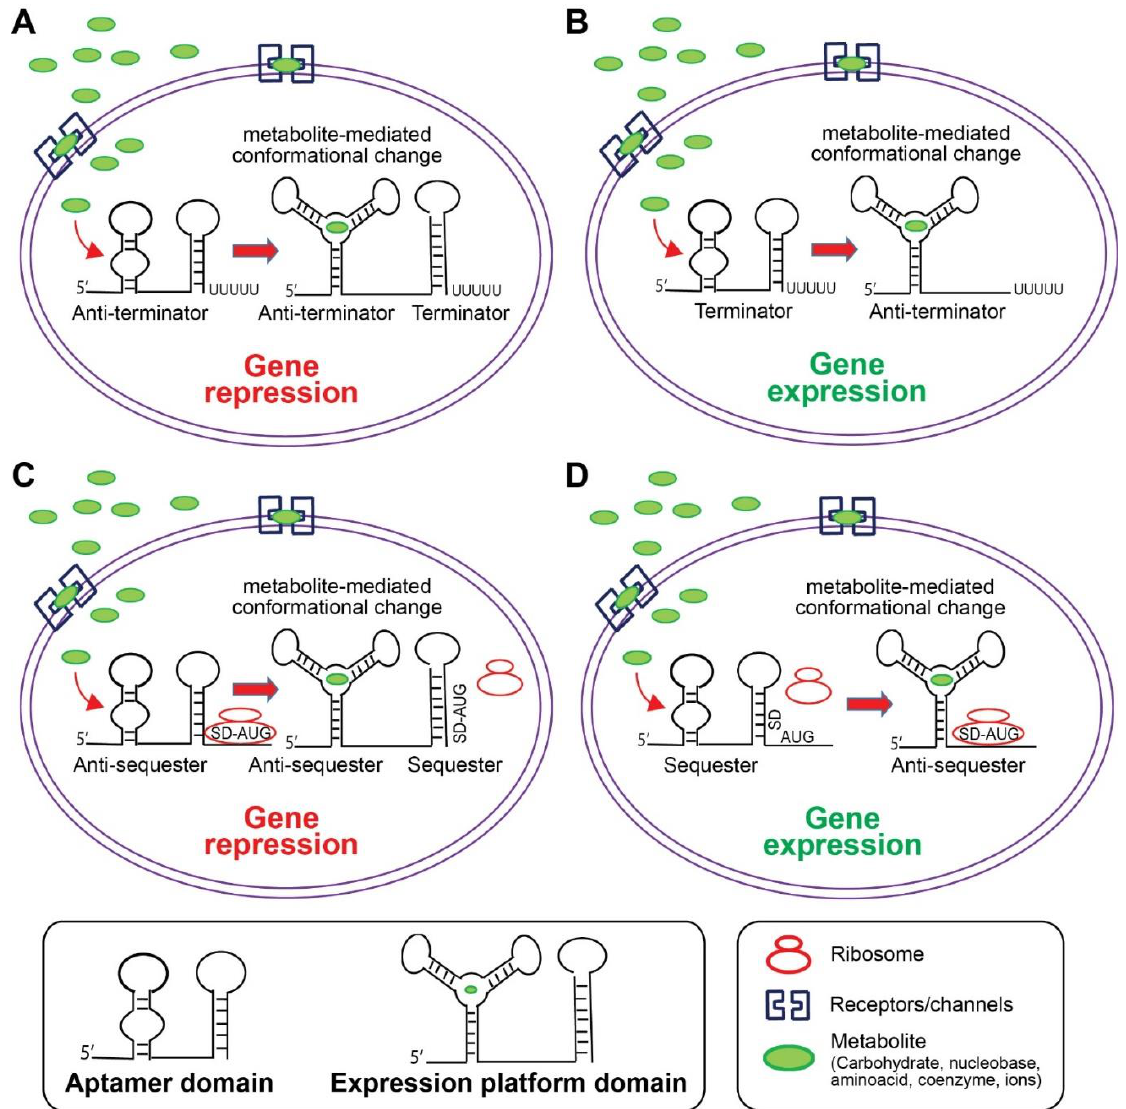
Figure 3. Gene regulation mediated by riboswitches. Bacterial riboswitches modulate their conformation in response to changes in the metabolite concentration and regulate the expression of downstream genes. Metabolite binding causes the repression or activation of downstream gene expression through transcription and/or translation. ( A ) Certain metabolite represses transcription through the formation of a specific step-loop structure (terminator) which stalls ribosome. ( B ) Certain metabolite activates transcription through the formation of a step-loop structure (anti-terminator), which allows ribosome to pass the mRNA. ( C ) Certain metabolite represses translation through the formation of a step-loop structure (sequester), which prevents ribosome’s access to the Shine–Dalgarno (SD) sequence. ( D ) Certain metabolites activate translation through the formation of a step-loop structure (anti-sequester), which facilitates ribosome’s access to the SD